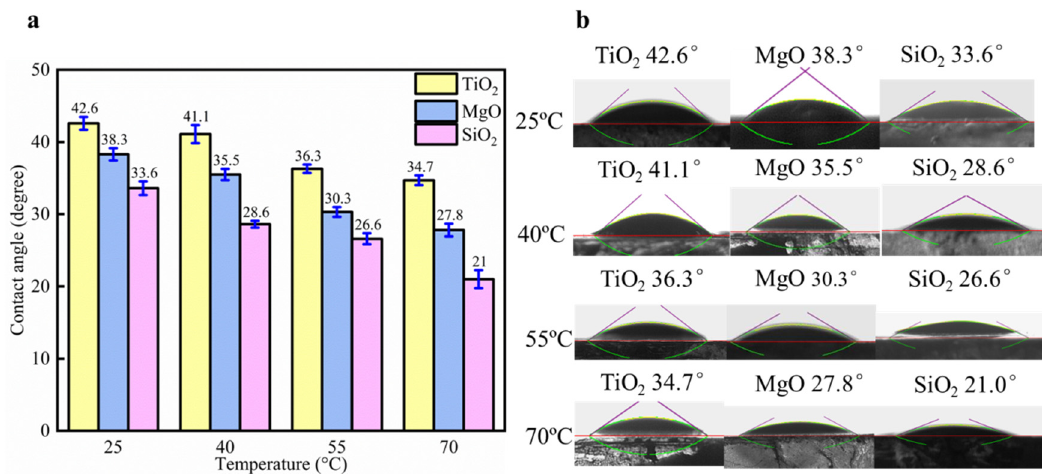
Figure 16. Temperature effect on oil-wet calcite for 0.1 wt% TiO 2 , MgO, and SiO 2 nanofluids. ( a ) Contact angle histogram; ( b ) Measurement figure.